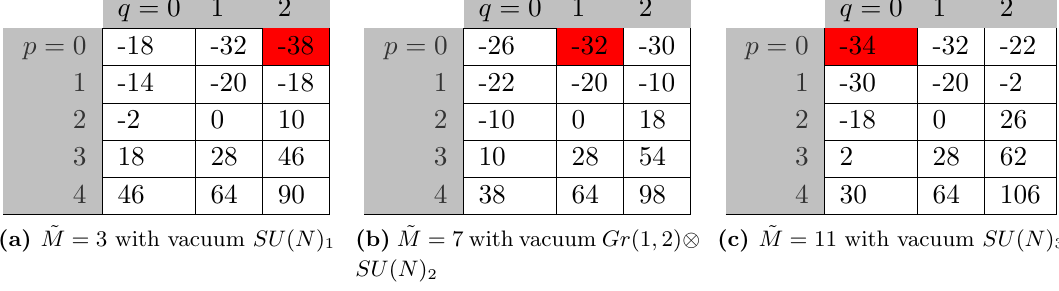
Table 1. Various values of the e(cid:11)ective potential with ~ m = 12. This follows trajectory 1 as shown in 6. The minimum is shown in red.